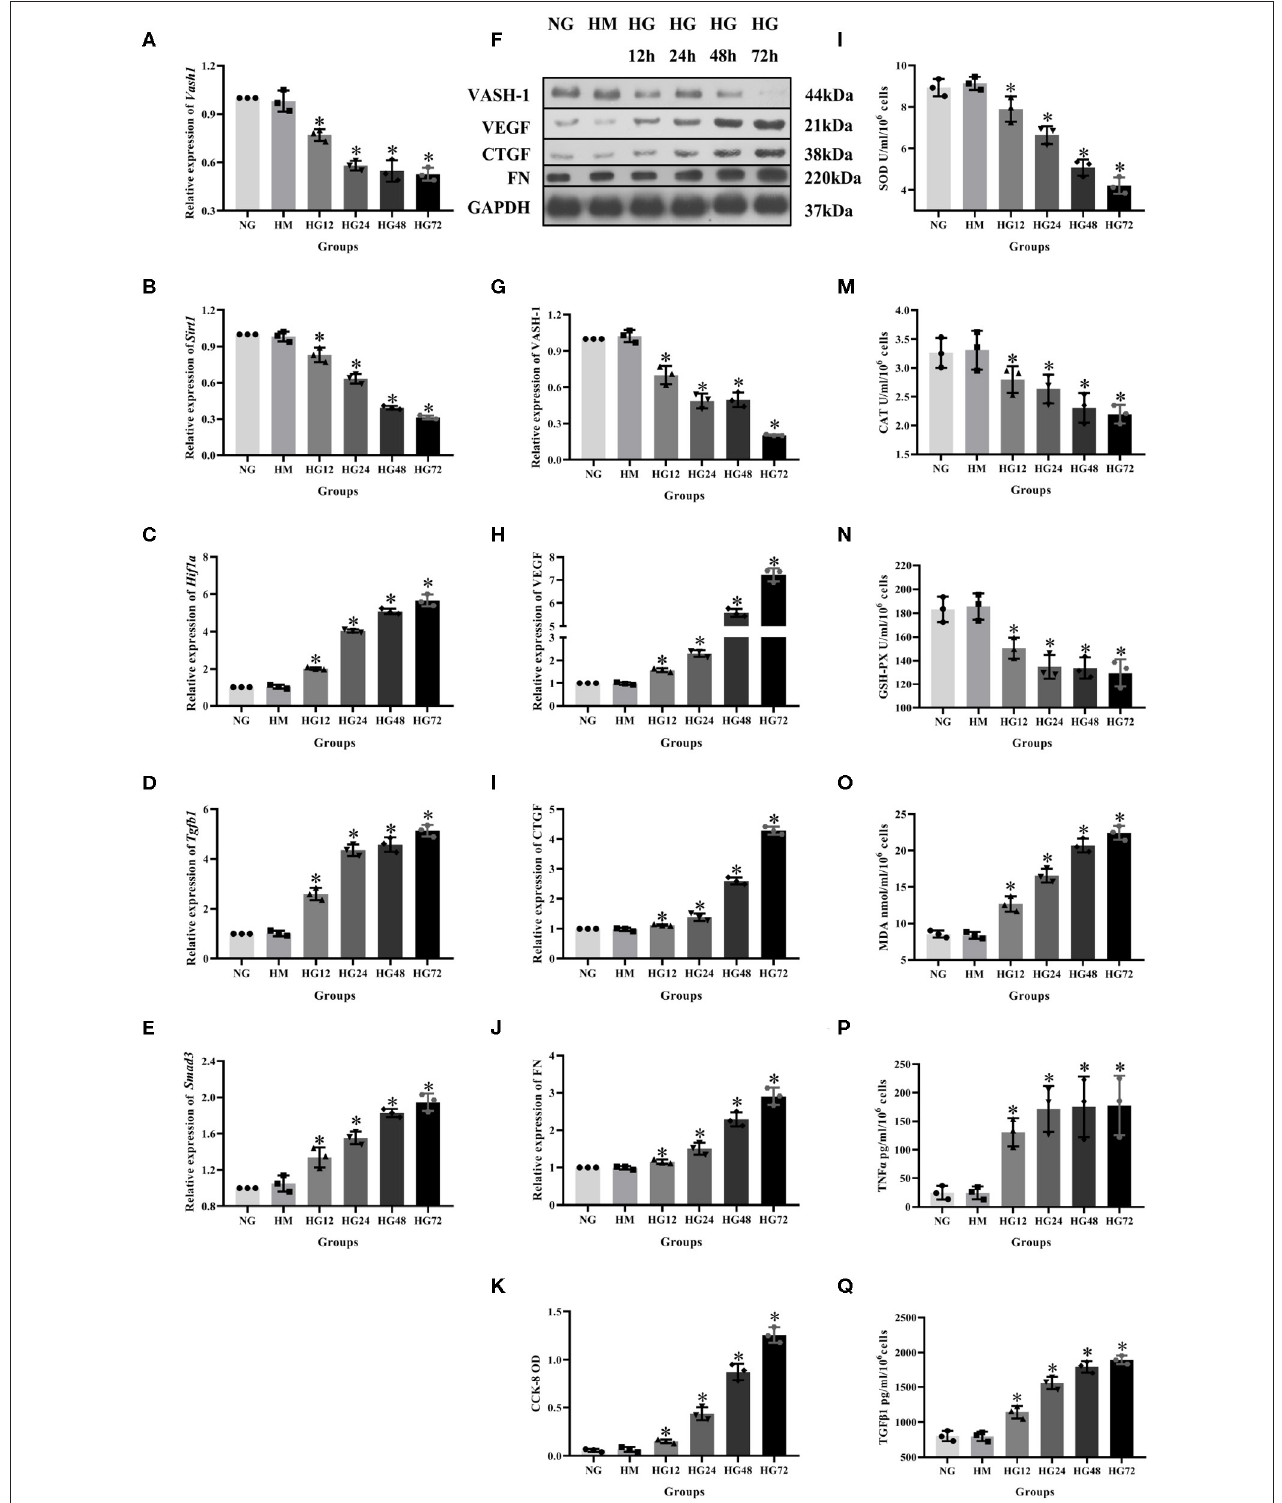
FIGURE 4 | Expression levels of RMCs at different timepoints with high glucose culture. Relative expression of (A) Vash1 , (B) Sirt1 , (C) Hif1a , (D) Tgfb1 , (E) Smad3 mRNA, (F) western blot protein band, relative expression levels of (G) VASH-1, (H) VEGF, (I) CTGF, (J) FN protein. (K) Detection of RMCs cell proliferation changes in CCK-8. Cell supernatant expression levels of (L) SOD, (M) CAT, (N) GSH-PX, (O) MDA, (P) TNF α , (Q) TGF β 1. *Compared with the NG group, P < 0.05. Data were expressed as mean ± SD, and results were repeated three times.